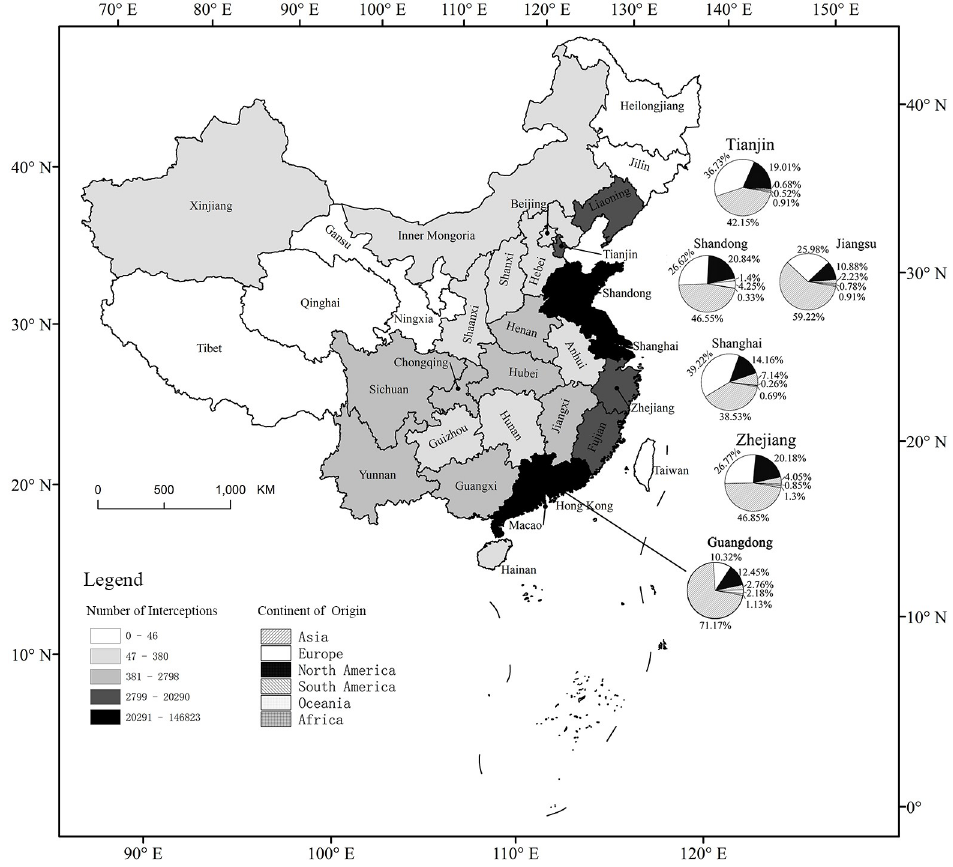
Fig 6. Number of exotic pests intercepted at inspection stations in each province and the percentage of exotic pests from major continents in the six provinces with the highest number of interceptions. CER = Cerambycidae, SCOL = Scolytidae, PLAT = Platypodidae, BOST = Bostrichidae, NEM = Nematode, SPI = Storage pests, US = United States, ZA = South Africa, CS = Czech Republic, HK = Hong Kong, GB = United Kingdom, NZ = New Zealand, SA = Saudi